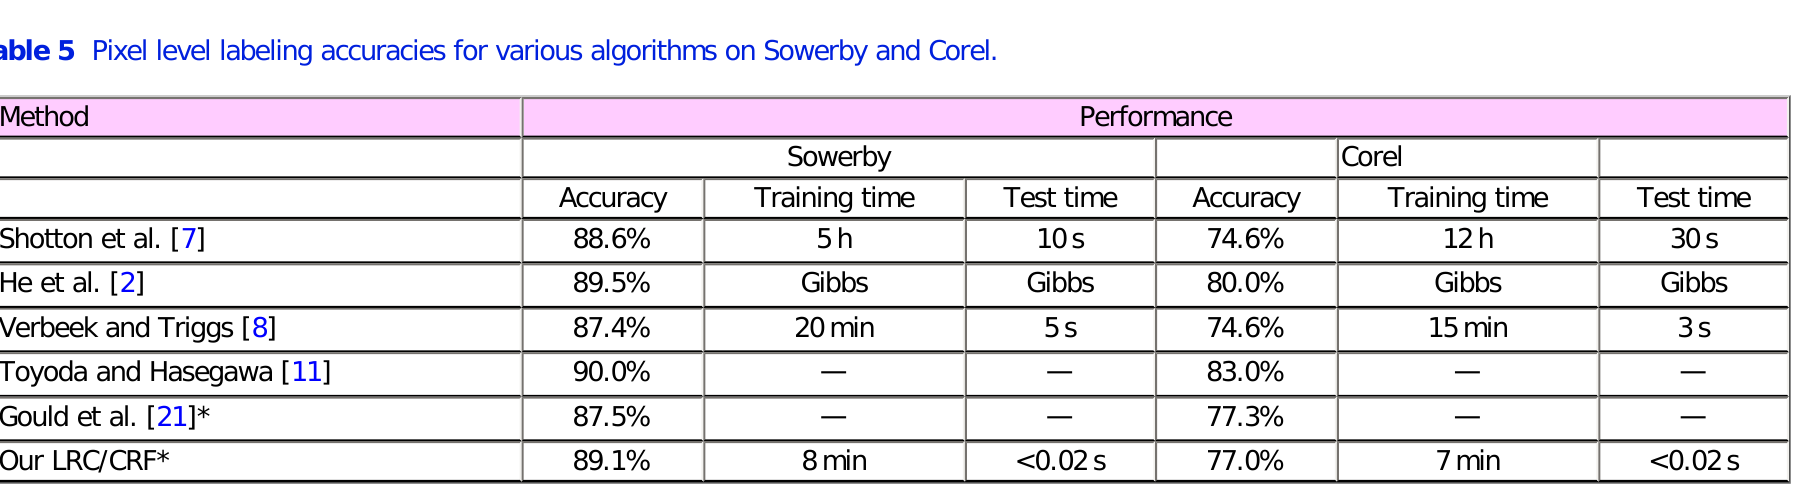
Figure 4 Illustrative labeling results on (a) Sowerby and (b) Corel. Columns from left to right: (a) input images; (b) first stage LRC, mapped to pixel level using the nearest-patch-center method; (c) LRC/LRC with MRF smoothing; (d) LRC/CRF with oversegmentation; (e) hand-labeled ground